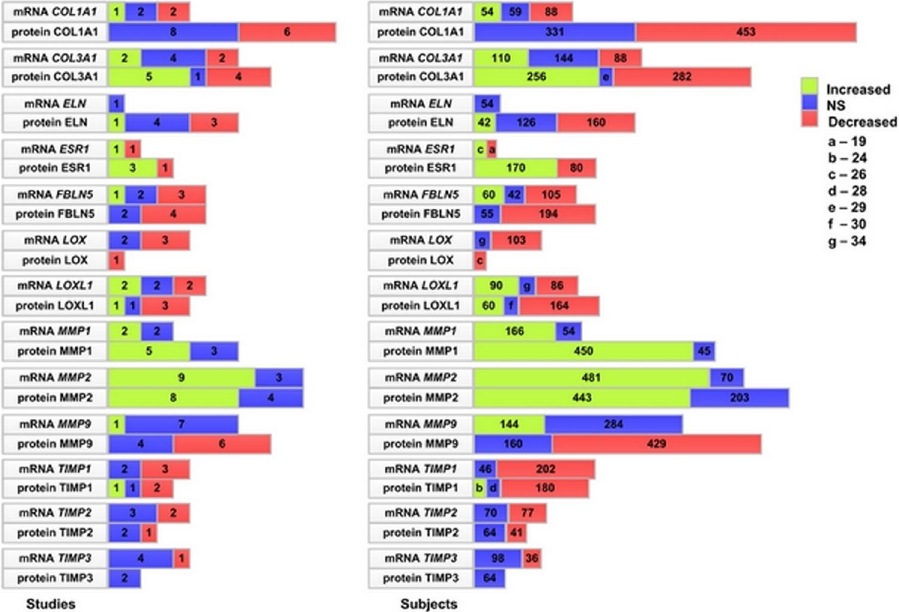
Figure 1. Summary of literature data on POP-related expression changes for selected genes. Numbers in boxes indicate the number of studies (Fig. 1a) and subjects (Fig. 1b) for each marker. Letter symbols ( a–g ) in the small boxes are decrypted in the right upper